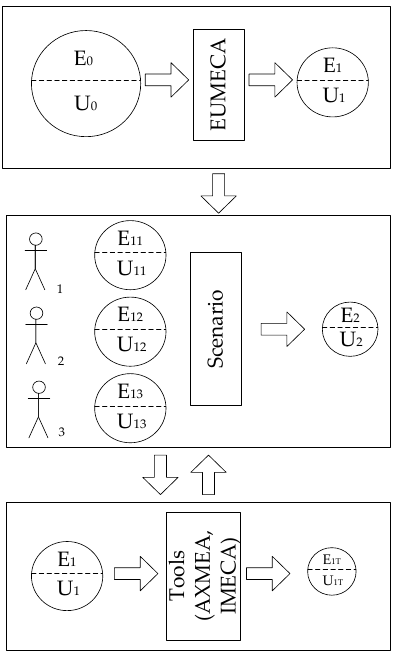
Figure 1. Overall relation between principles and E/U sets.